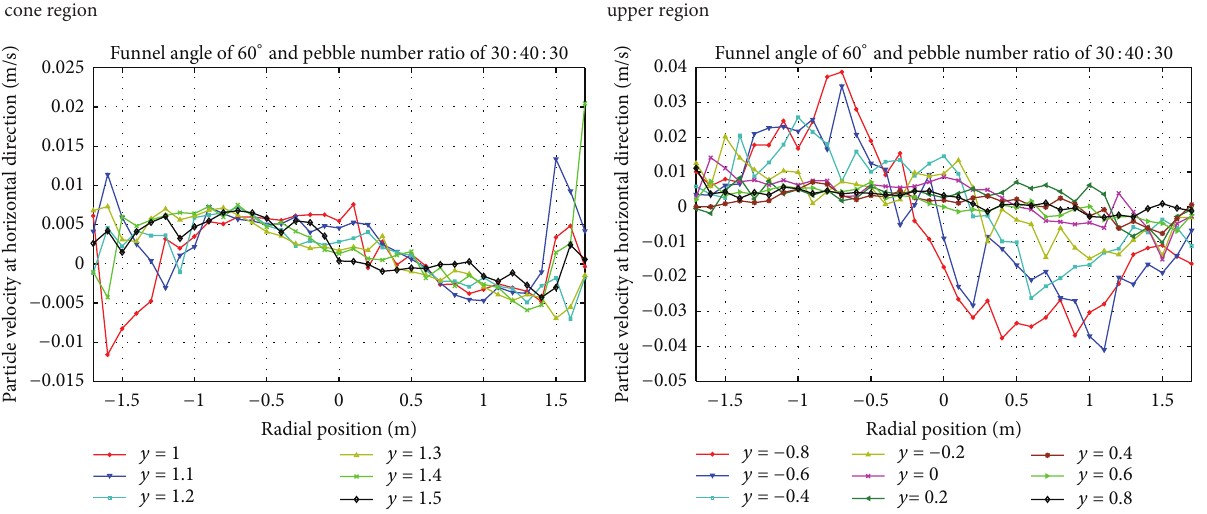
(d) Horizontal velocity distribution of pebbles with funnel angel of 60 ∘ at upper region Funnel angle of 60 ∘ and pebble number ratio of 30 : 40 : 30